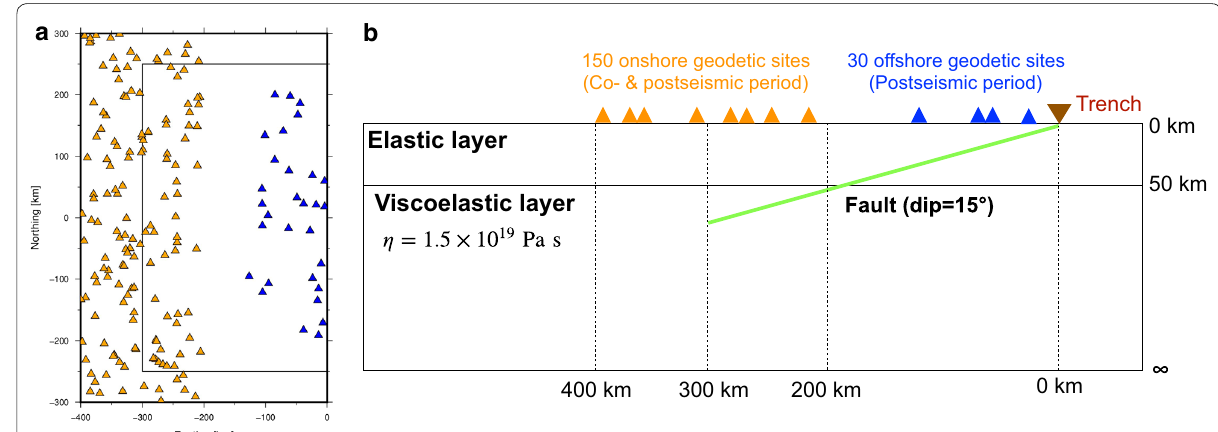
Fig. 6 Synthetic site distribution and rheological structure for the dip–slip case. a Synthetic site distribution. Black rectangle represents the fault zone projected to surface. Orange triangles indicate synthetic GNSS sites for both co- and post-seismic period, while blue triangles indicate those only for post-seismic period. b A schematic image of cross section of rheological structure (the two-layered viscoelastic structure)